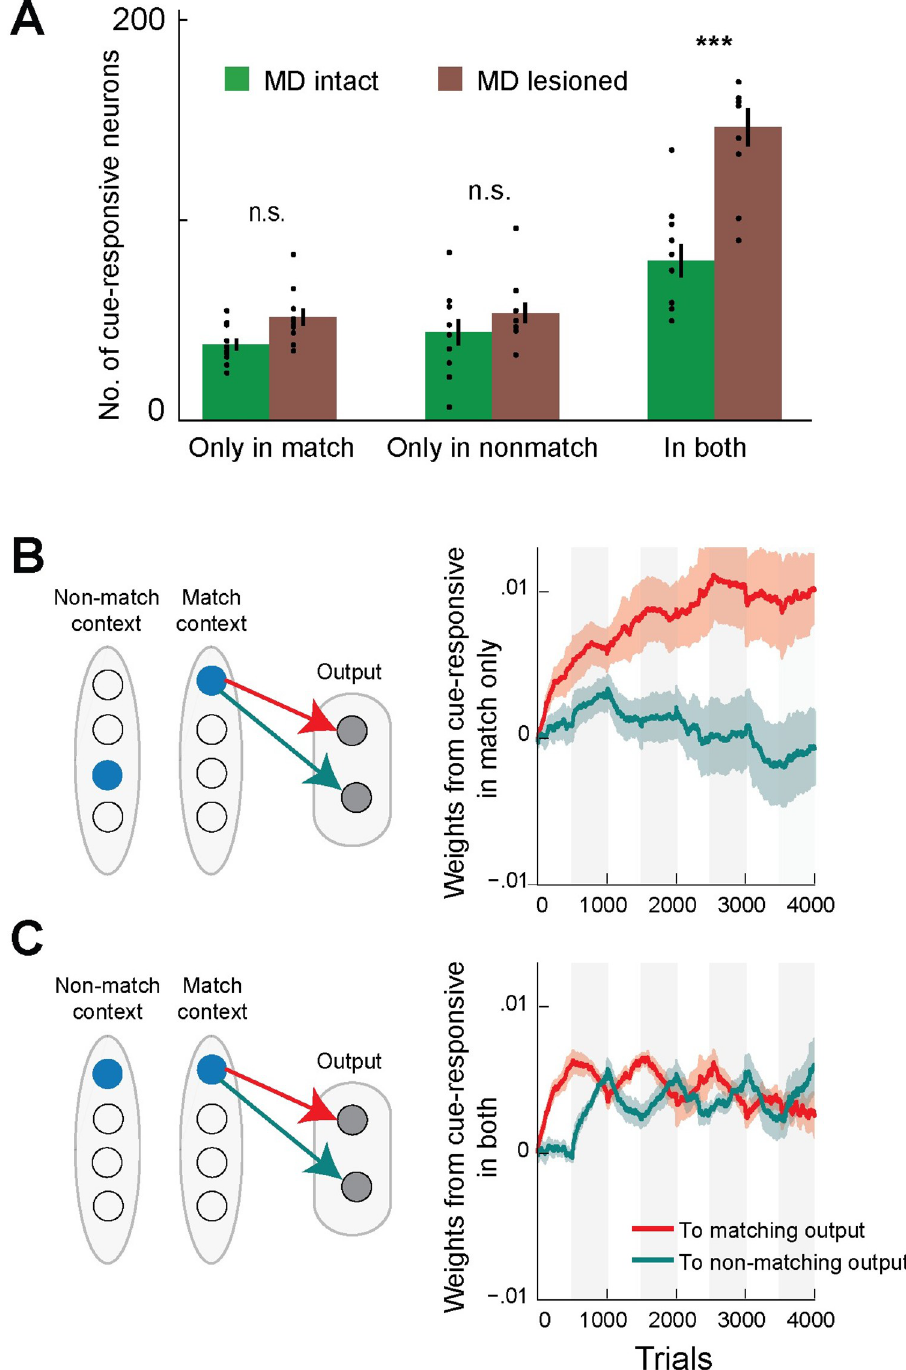
Fig 4. Selective dlPFC sensory representations in the MD intact neural model. A. We identified model dlPFC cells that were cue-responsive in one of the two behavioral contexts selectively and cells that were cue-responsive in both contexts non-selectively, using logistic regression. We found the most significant difference between the MD intact and MD lesioned models was an increase in non-selective cells with MD lesioning (Mann-Whitney U test, two-tailed, both contexts p-value 0.003, match-selective p = 0.210, non-match selective p = 0.449). Bars represent means ± SEM B. Schematic shows cartoon of cells that were cue-responsive only in one of the behavioral contexts, and the connections to the appropriate output cell (left). These cells had their weights to the appropriate output neuron increase coherently in the corresponding behavioral context and remain dormant out of context (right). C. In comparison, cells that